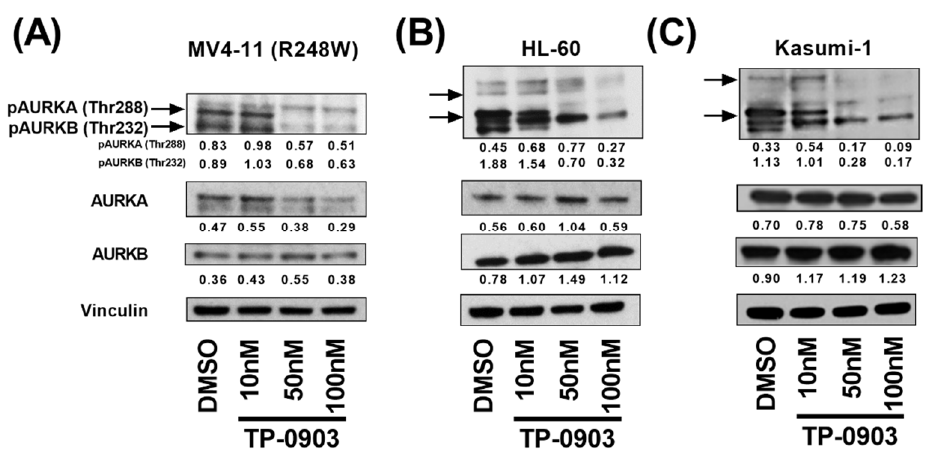
Figure 1. TP-0903 inhibits aurora kinases in TP53 mutant AML cell lines. ( A ) MV4-11 (R248W) ( B ) HL-60 or ( C ) Kasumi-1 cells were treated with DMSO or increasing concentrations of TP-0903 for 4 h. Western blot analysis was performed on whole-cell lysates run on parallel gels with the indicated antibodies. Vinculin served as the loading control for each lysate. Immunoblots were quantified against respective loading controls using ImageJ. Data are representative of 3 independent experi- ments.